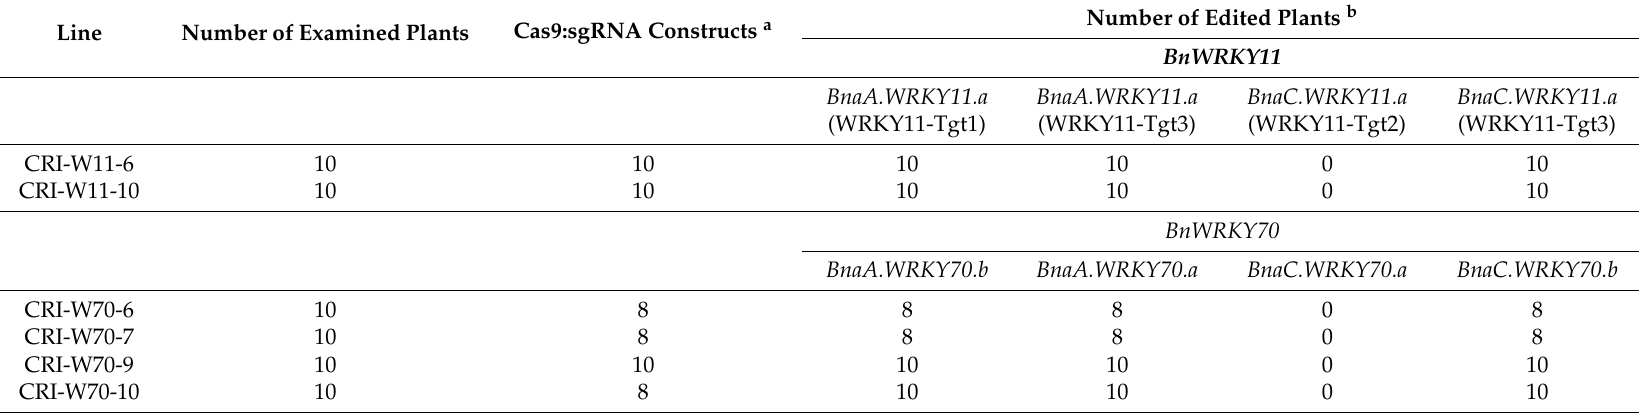
Table 2. Sum of the edited T 1 plants of CRI-W11 and